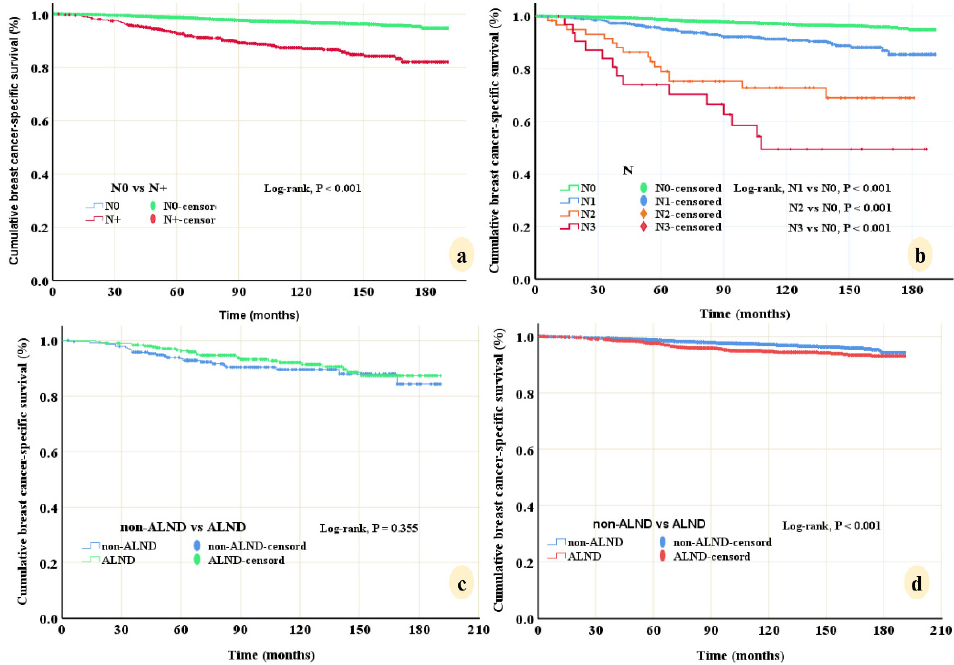
Figure 3. Prognostic value of lymph node metastases of breast cancer-specific survival (BCSS), and survival benefit of axillary lymph node dissection (ALND) for microinvasive breast cancer. ( a ) N+ subgroup had lower 10-year BCSS than N0 subgroup (87.4% vs. 97.0%, p < 0.001). ( b ) Lymph node metastases had the strongest prognostic weight (N3, HR 14.200; N2, HR 12.945; N1, HR 3.05, all p < 0.001). ( c ) ALND did not confer a survival benefit on 10-year BCSS (92.1% vs. 89.5%, p = 0.355) in patients with 1 – 2 positive nodes when compared to non-ALND surgery. ( d ) Patients received ALND even had a lower 10-year BCSS than patients with non-ALND (94.7% vs. 97.1%, p < 0.001) in the N0 cohort.